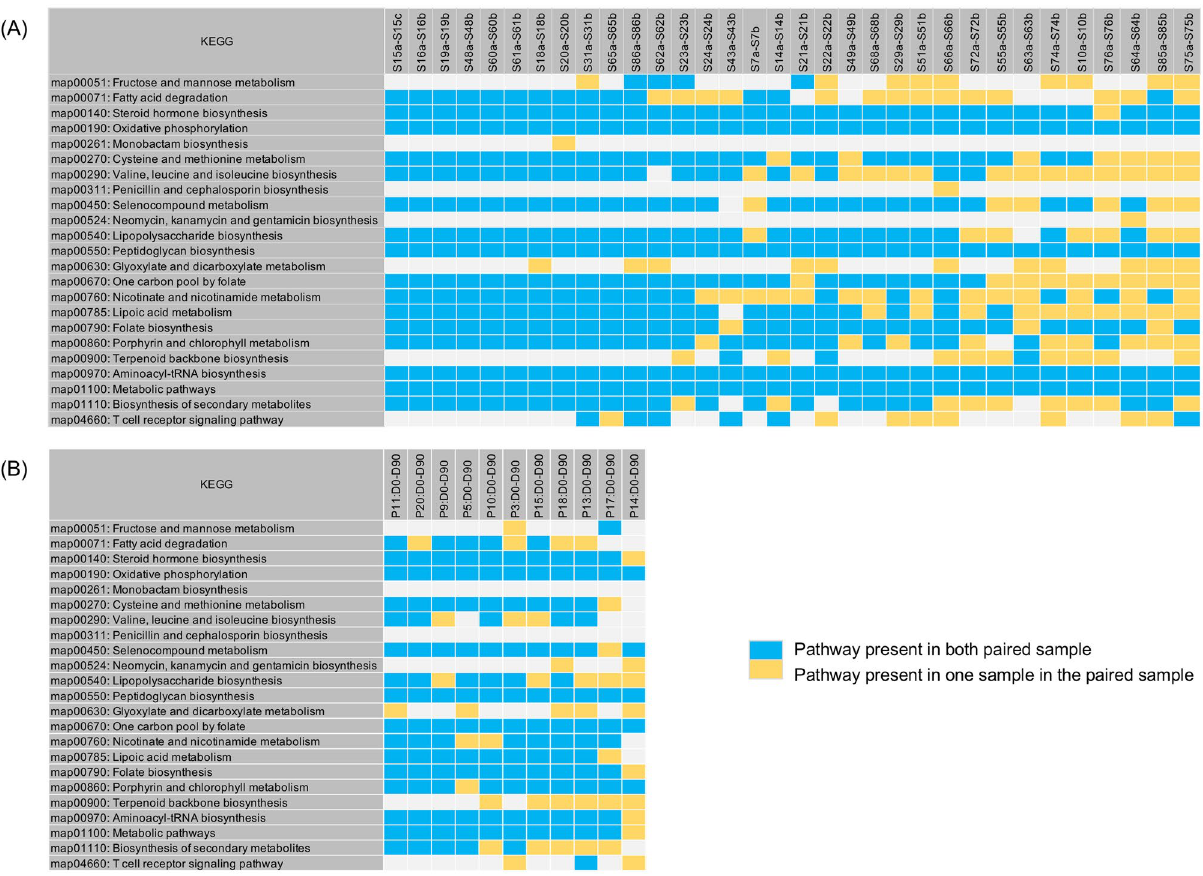
Figure 1. PKS results for healthy individuals. A total of 23 KEGG pathways were used to investigate a pattern of presence/absence of metabolic pathways for B. vulgatus. The summarized PKS result of the 23 KEGG pathways per individual related pair from ( A ) HMP 8 , and ( B ) Raymond et al. 24 data sets were grouped into different color boxes (colors scheme presented in the figure). Each column in the table indicates an individual’s paired samples and matches the number shown in Supplementary Table and 3). For B. vulgatus , there were no shared PKS patterns observed from three individuals (AAD, AAN, and AAG) between the times that were examined, ( i.e. AAD: 0 differences between 6 total pairs; AAN: 0 differences